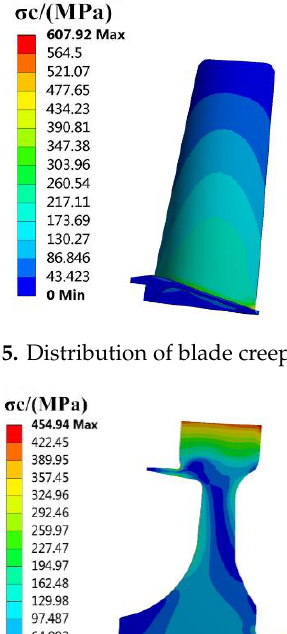
Figure 4. Finite element model of the disk.